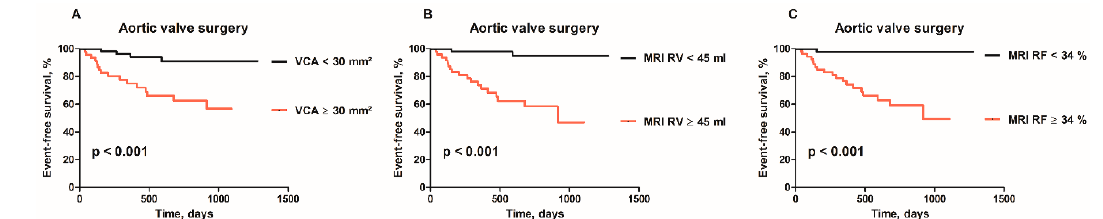
Figure 2. Receiver-operating characteristics curves of the MRI-derived: regurgitant volume (RV) and left ventricular end-diastolic volume index (LVEDVI); the 3D ECHO-derived: vena contracta area (VCA); 2D ECHO-derived: left ventricular end-systolic diameter (LVESD); RV and global longitudinal strain (GLS) to predict AV surgery.